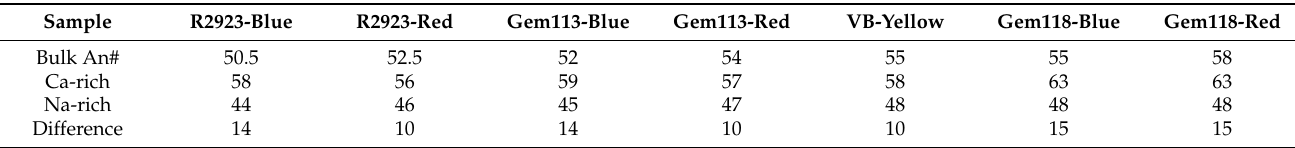
Table 2. The bulk and lamellar compositions (in An#) of the iridescent labradorite samples were calculated from the EDS maps. The raw EDS intensity ratios of each lamella pair can be found in Table S2. Sample